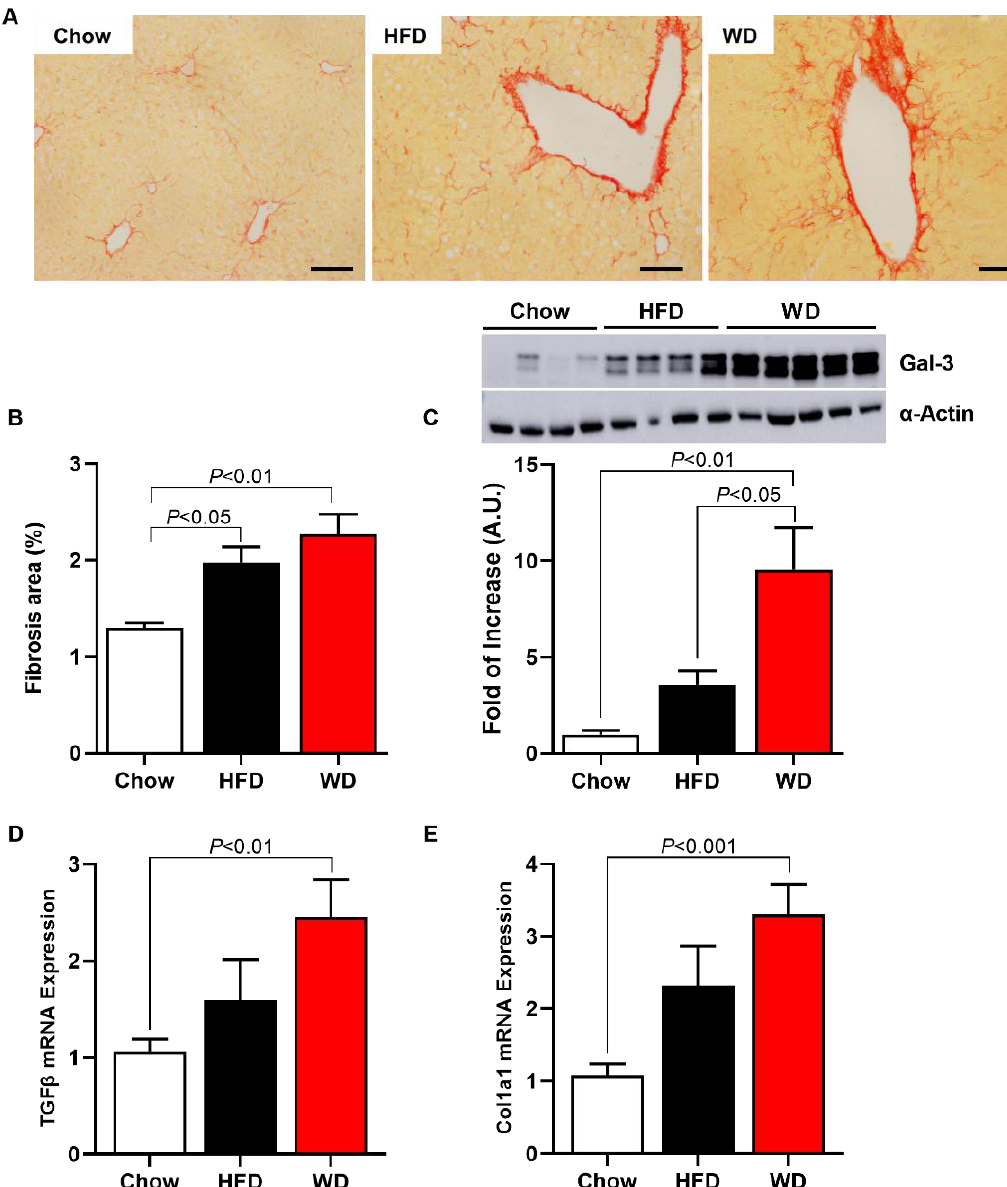
Figure 3. ApoE KO Mice fed an HFD or WD displayed increased hepatic fibrosis. Representative images of collagen deposition, picrosirius staining (scale of 50 µ m, objective 40 × ) ( A ). Area fibrosis ( B ). Protein expression of galectin-3 (representative images—Western blot) ( C ). Pro-fibrogenic gene expression ( D , E ). Data are represented as mean ± SEM (N = 5–9). The statistical differences as indicated by one-way ANOVA.